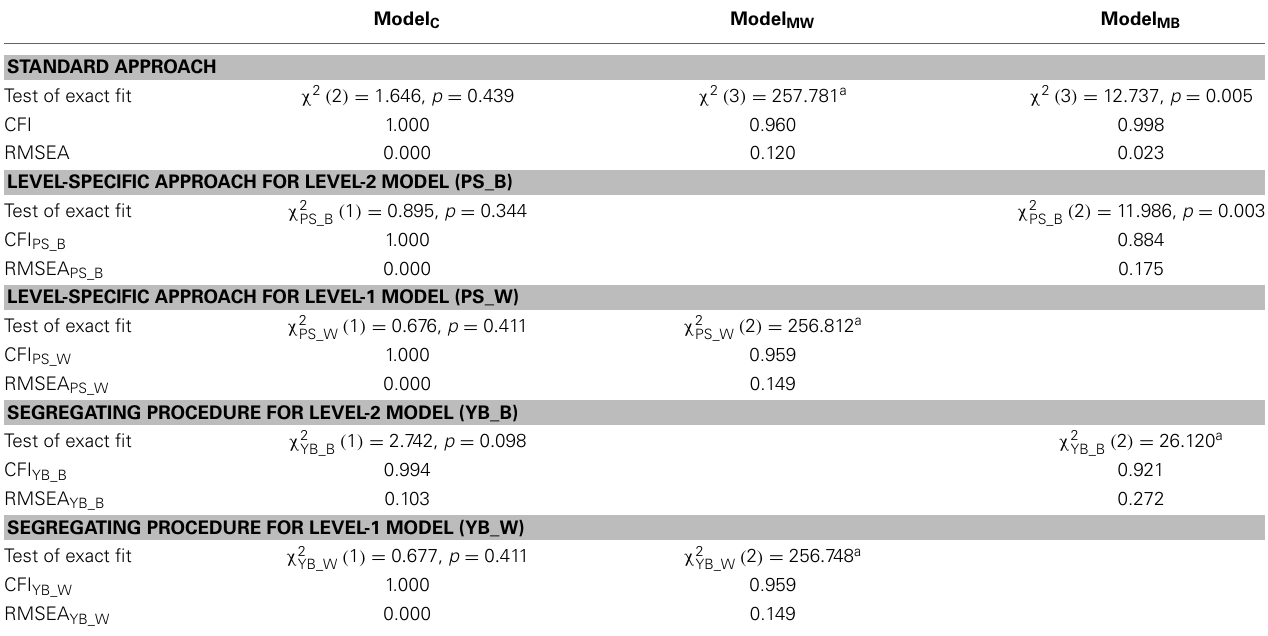
Table 1 | Model fit statistics obtained by the standard, level-specific, and segregating